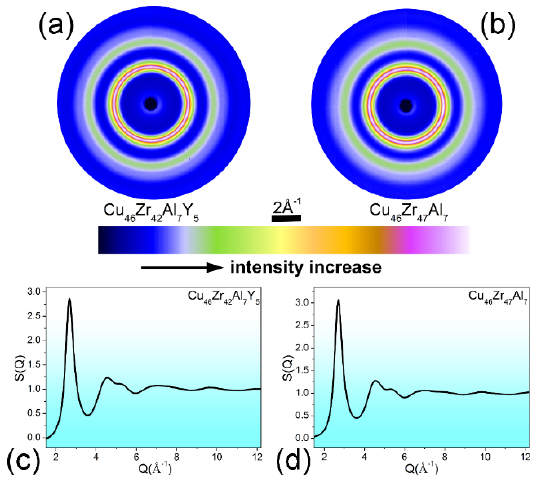
Figure 1. The two ‐ dimensional X ‐ ray diffraction (XRD) patterns in ( a ) Cu 46 Zr 42 Al 7 Y 5 and ( b ) Cu 46 Zr 47 Al 7 amorphous samples; and the deduced data, including: the structural factors ( S ( Q )s) of ( c ) Cu 46 Zr 42 Al 7 Y 5 and ( d ) Cu 46 Zr 47 Al 7 . To highlight oscillations in low Q region of S ( Q ), the Q region here was shortened to about 12 Å − 1